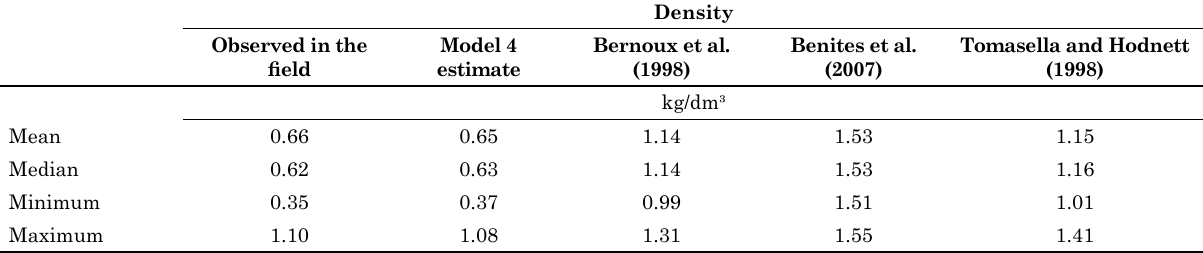
Table 4. Descriptive statistics for observed densities and for densities estimated by the regression